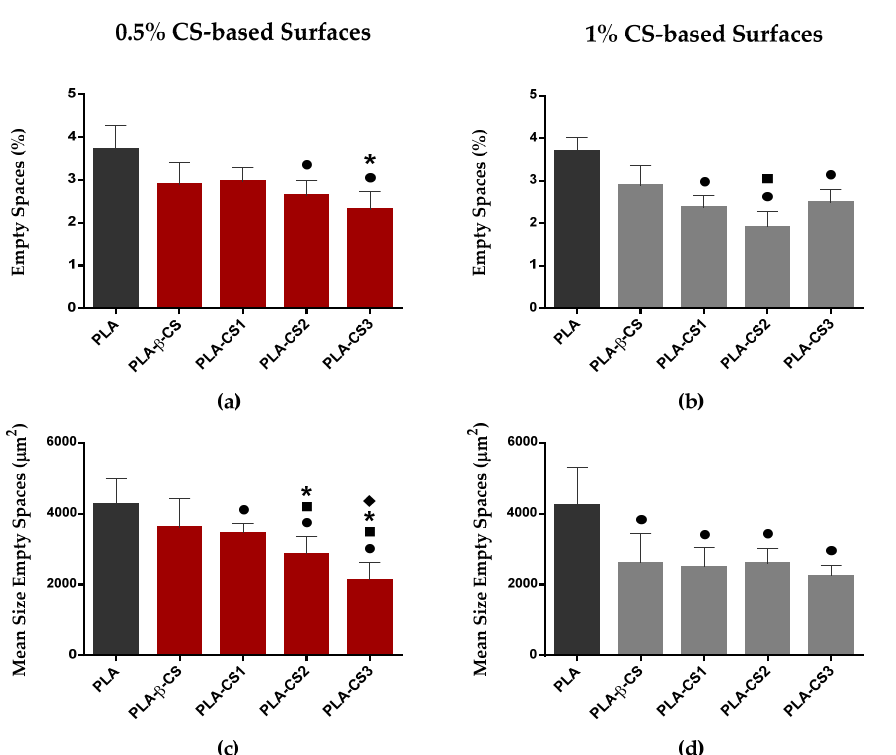
Figure 5. Mean percentages ( a , b ) and size ( c , d ) of empty spaces presented on ■ PLA, and ■ 0.5% and ■ 1% (w/v) CS-coated PLA surfaces (PLA- β -CS, PLA-CS1, PLA-CS2, and PLA-CS3) after 49 days. Differences between functionalized surfaces were evaluated using the non-parametric Mann– Whitney test and represented for p-values < 0.05 by ● , ■ , * and ◆ when compared to PLA, PLA- β -CS, PLA-CS1, and PLA-CS2, respectively.